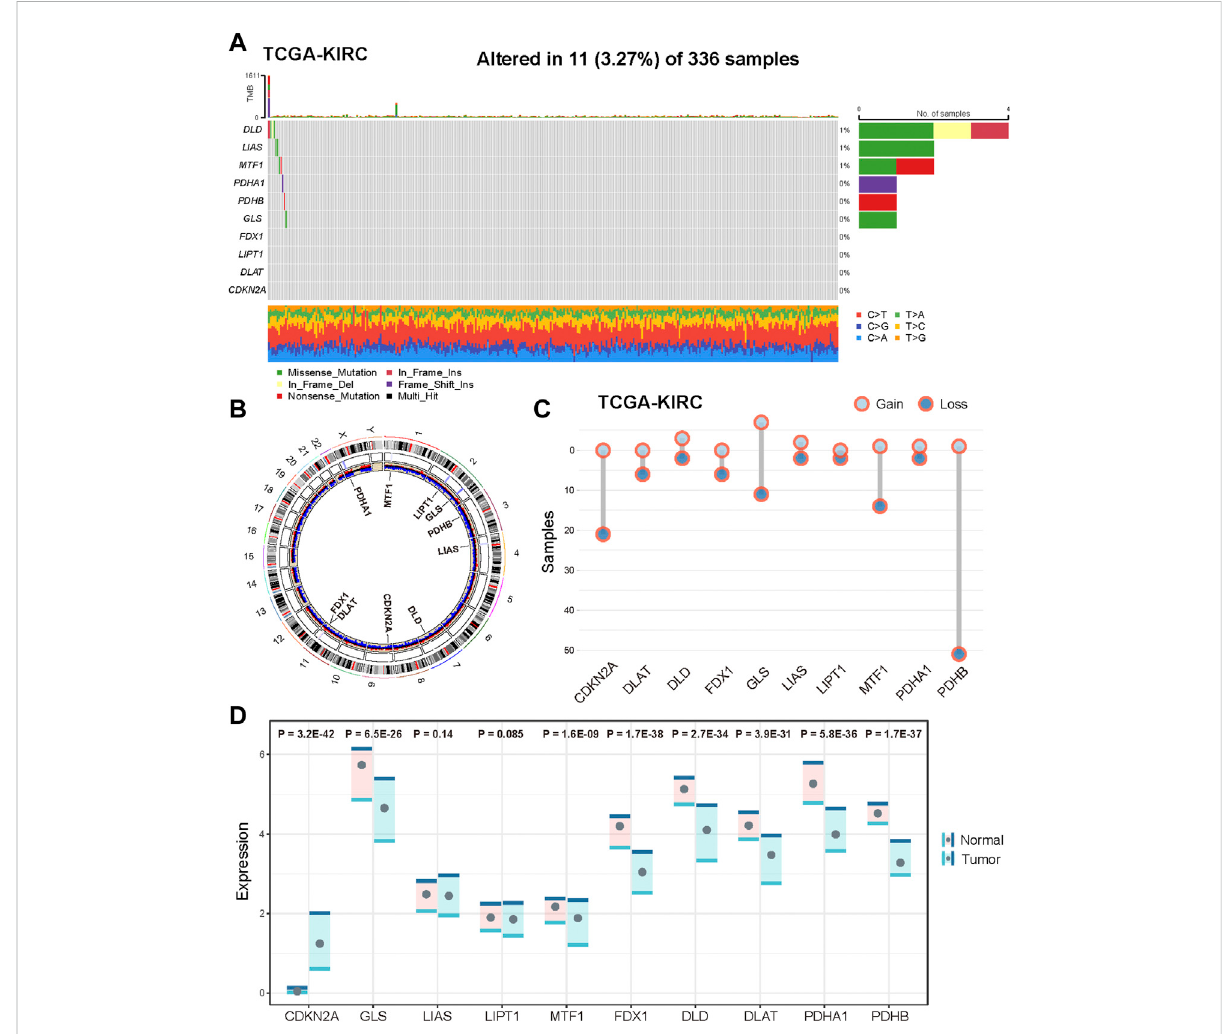
FIGURE 1 Genetic and transcriptional alterations of CID genes in KIRC. (A) Mutation frequencies of CID genes in KIRC patients of TCGA cohort. (B) Locations of CNV alterations in CID genes on 23 chromosomes and distribution of expression. (C) Frequencies of CNV ampli fi cation and deletion of CID genes in TCGA KIRC cohorts. (D) Differential expression of CID genes between tumor and normal